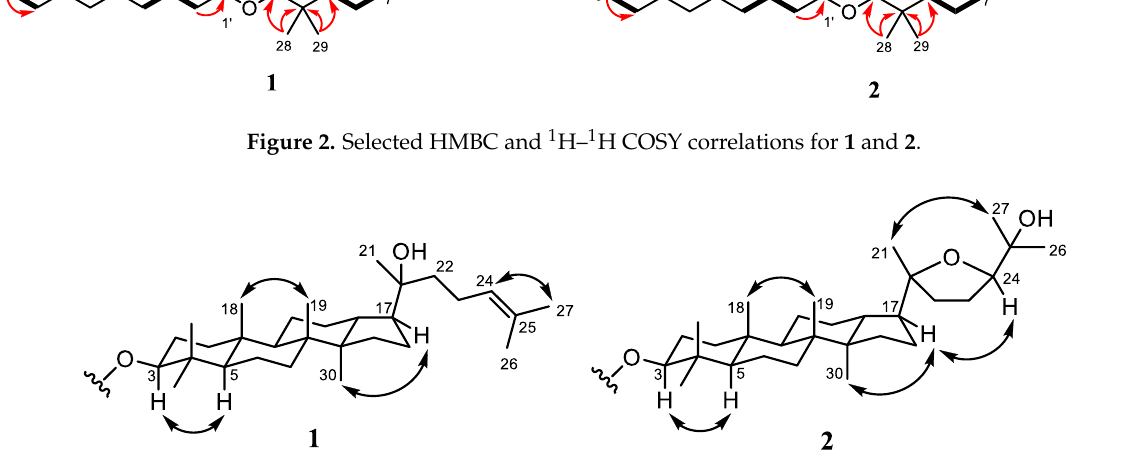
Figure 3. Selected NOESY correlations for 1 and 2 .